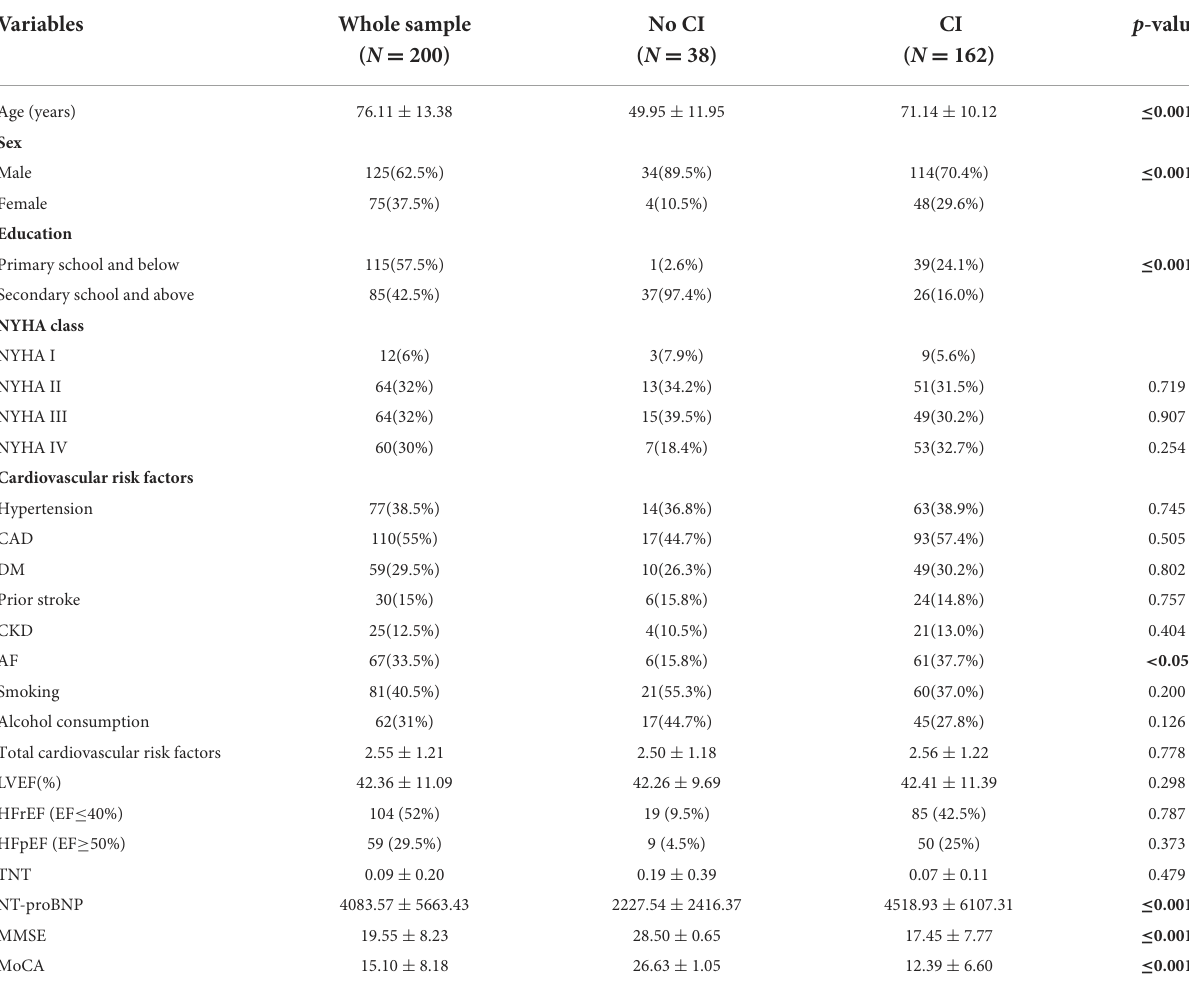
TABLE 1 Study sample